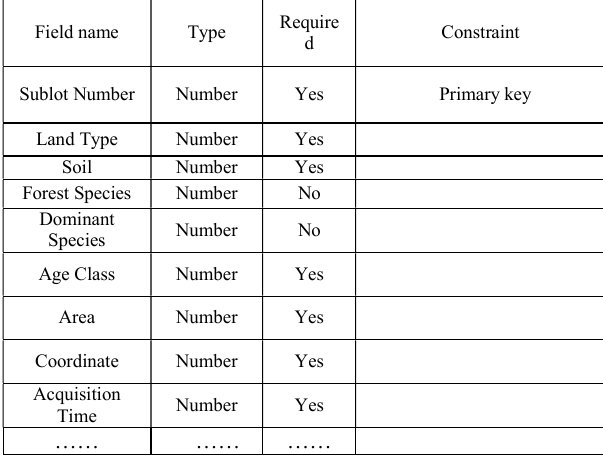
Table 1Partial data of sublot survey